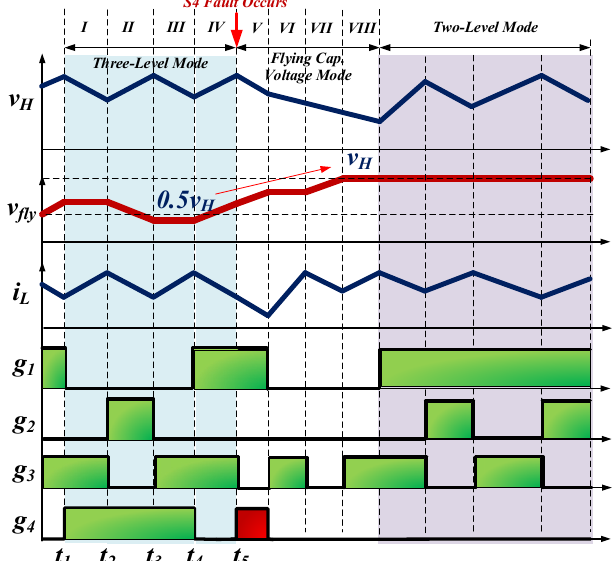
Figure 8. Stage analysis (V L < 0.5 V H ).